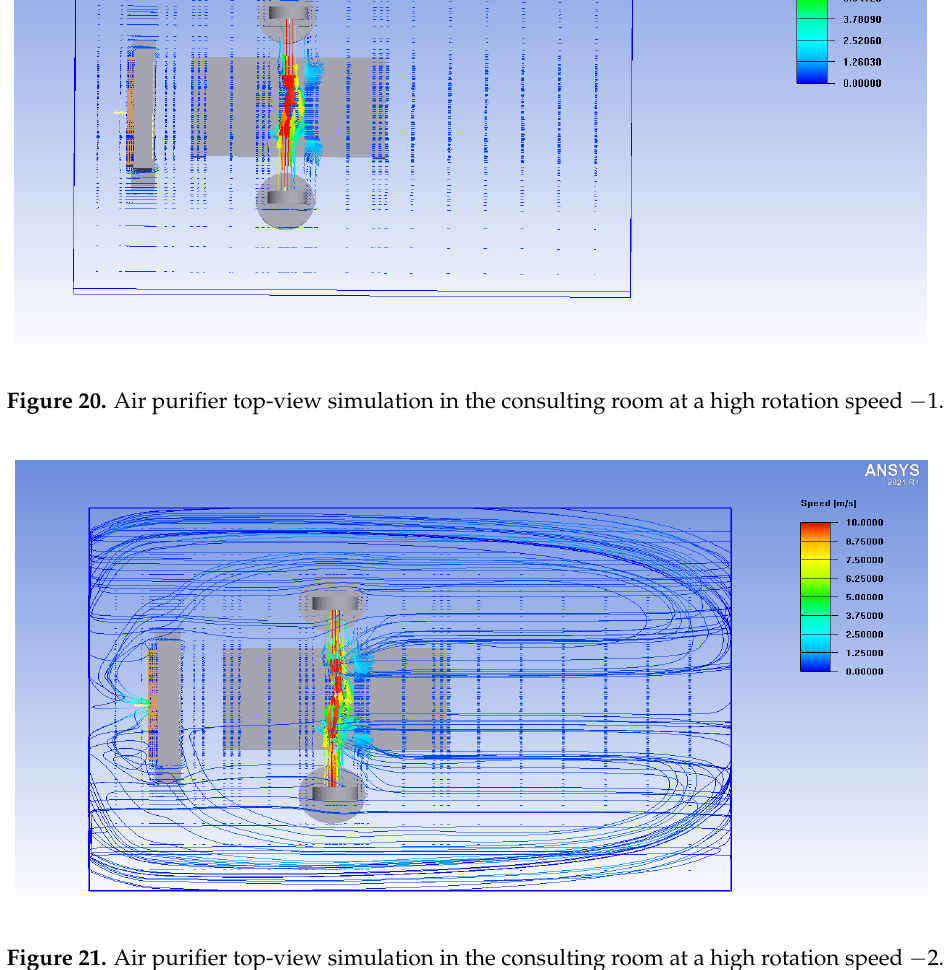
Figure 21. Air purifier top-view simulation in the consulting room at a high rotation speed -2.